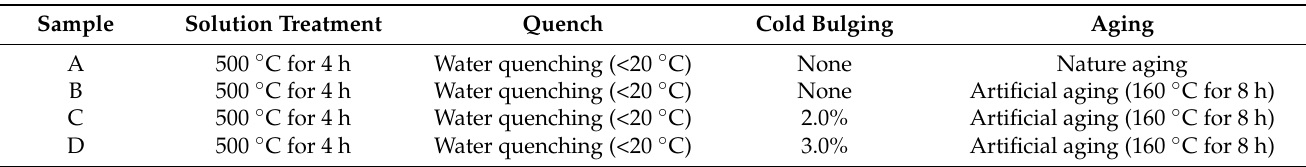
Figure 2. Dimensions of the reduced-scale tapered cylinder forging samples and stress test locations. Table 2. Summary of cold bulging treatment